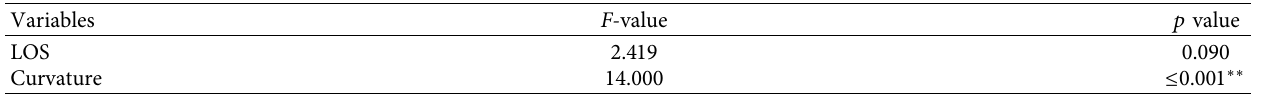
Table 10: Significance of road traffic measures on stabilization time.